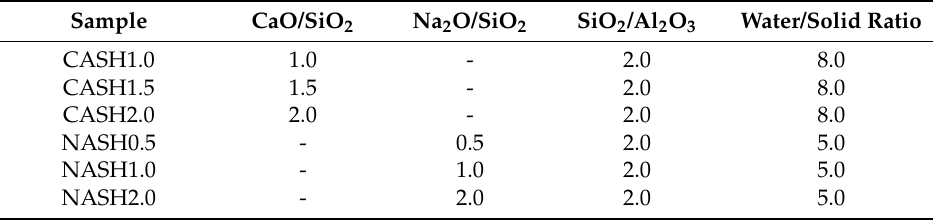
Table 1. Mixing proportions used to prepared CaO-Al 2 O 3 -SiO 2 -H 2 O (C-A-S-H) and Na 2 O-Al 2 O 3 -SiO 2 - H 2 O